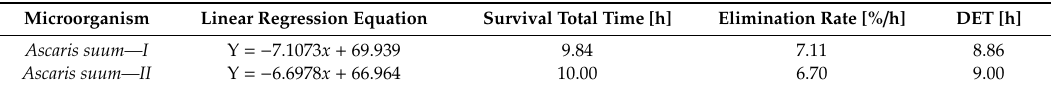
Table 4. Statistical parameters of the A. suum inactivation kinetics in laboratory scale.